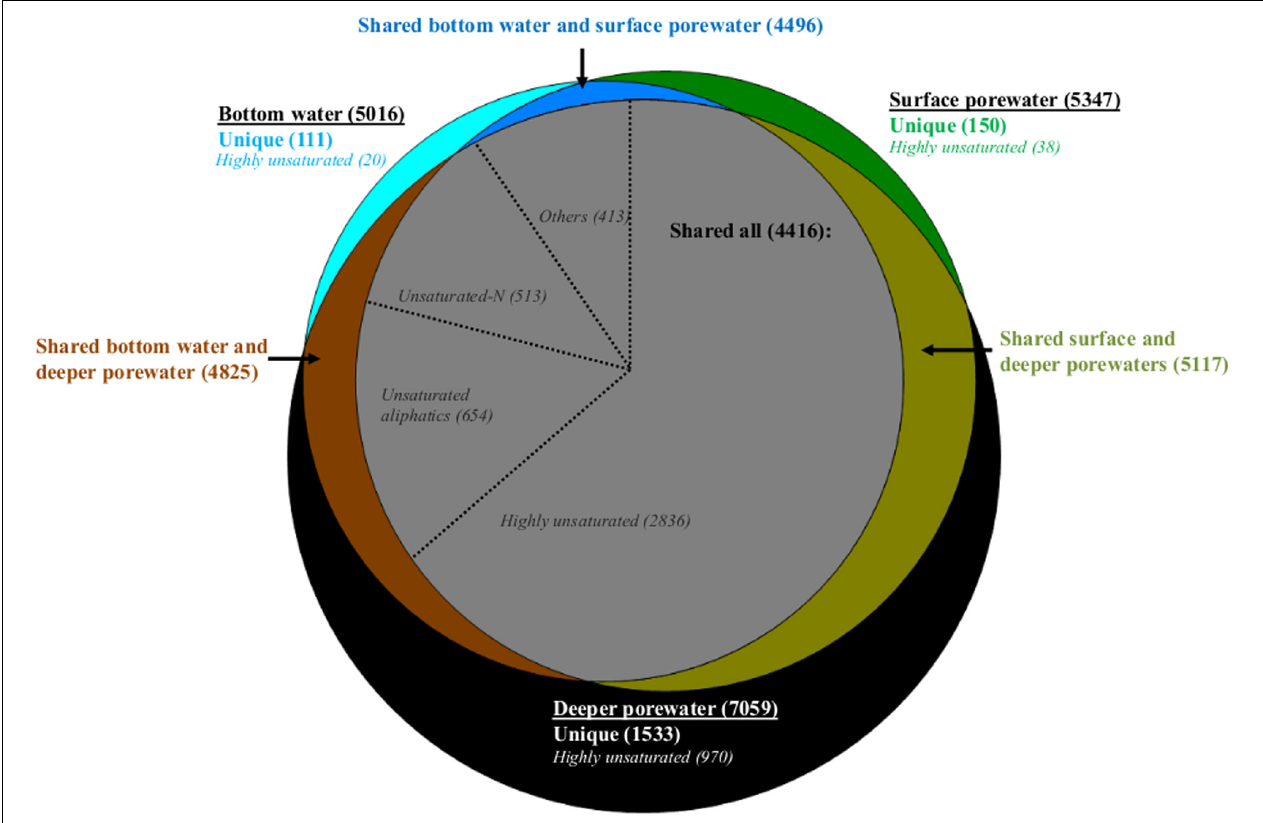
FIGURE 4 | Venn diagram with molecular formulas identified in the whole dataset. Number of formulas detected in bottom water, surface (0–1 cm) and deeper porewater (1–5, 5–10 cm) pools are indicated in bold inside the parentheses. Number of unique formulas in each pool and those shared between two or all pools are color coded and displayed in parentheses. Number of formulas contributing to specific molecular categories are indicated in italics also in parentheses. In the gray circle (with formulas shared between the three pools) “others” represent the sum of aromatics, polyphenols and